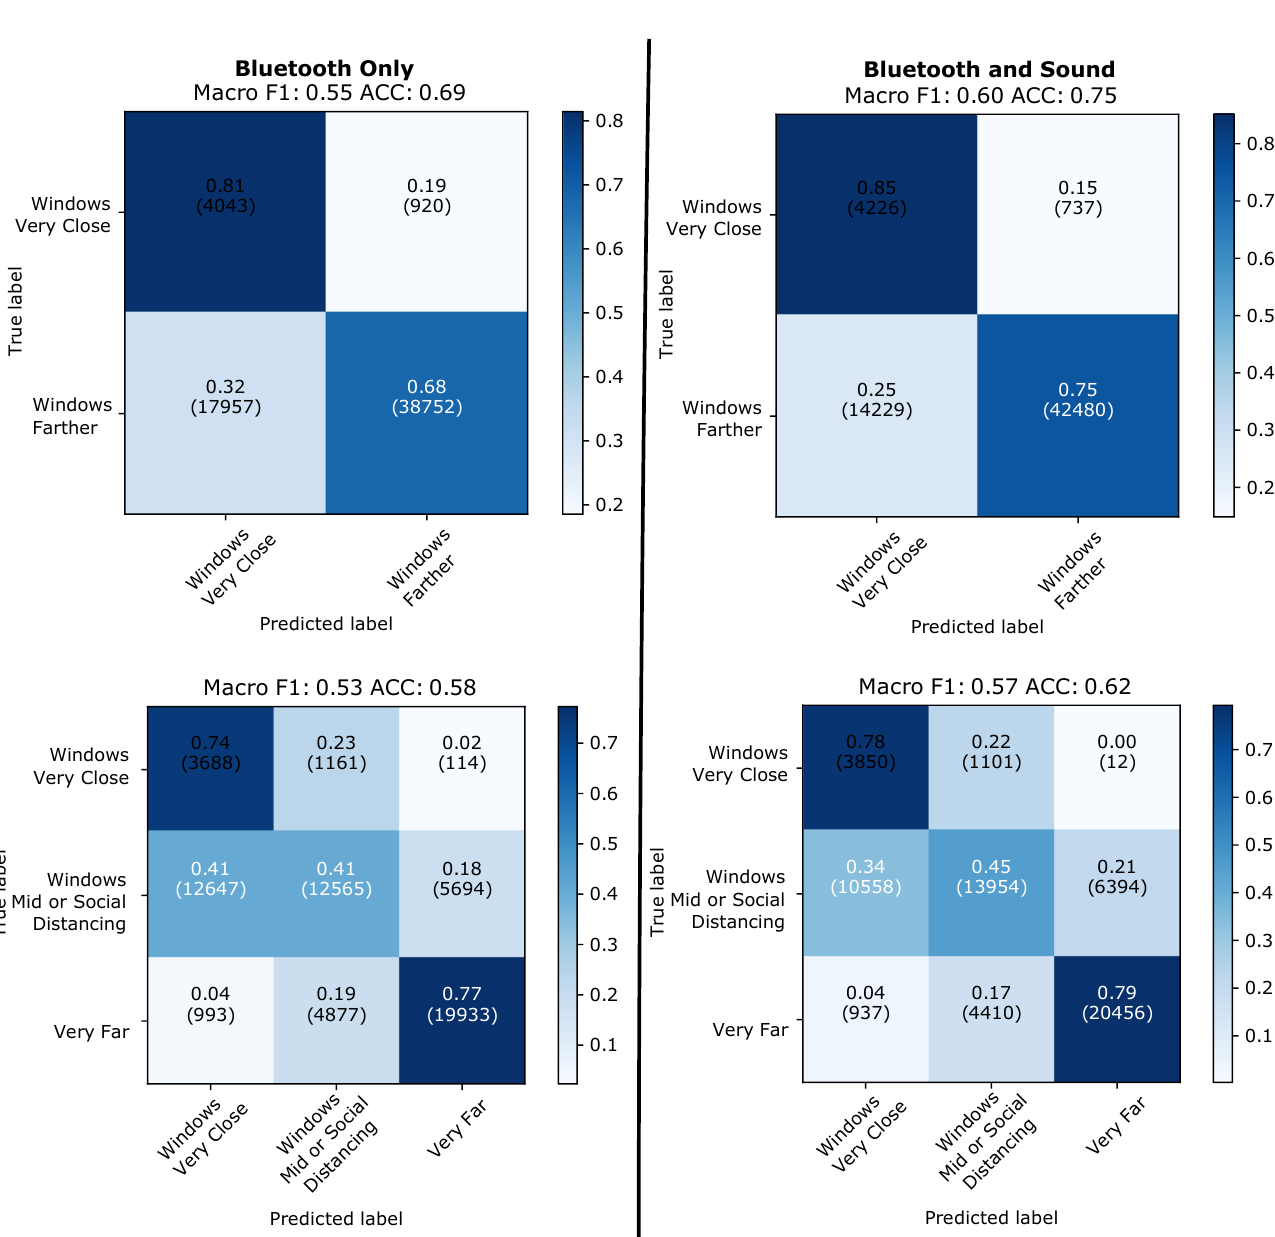
Figure 16. Train one type test another. Results for all